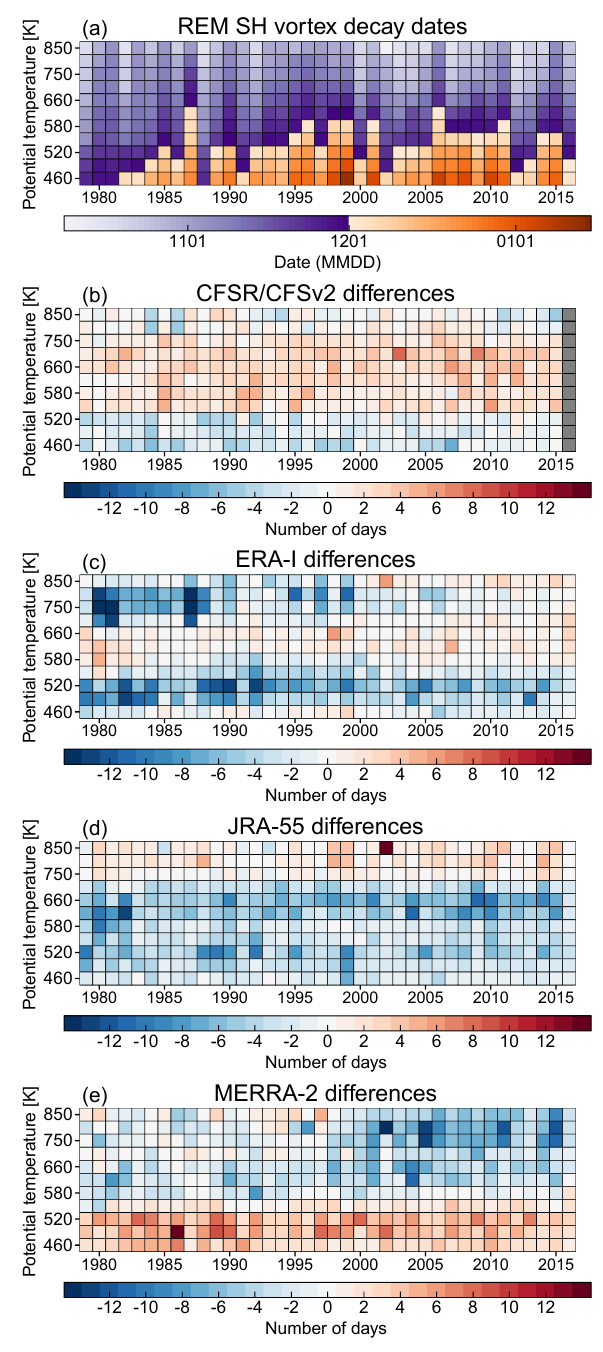
Figure 17. Pixel plots of (a) vortex decay dates (see text for the def- inition) based on the REM of vortex area, and ( b – e ) the difference between the vortex decay dates in each of the reanalyses from the REM (as reanalysis −